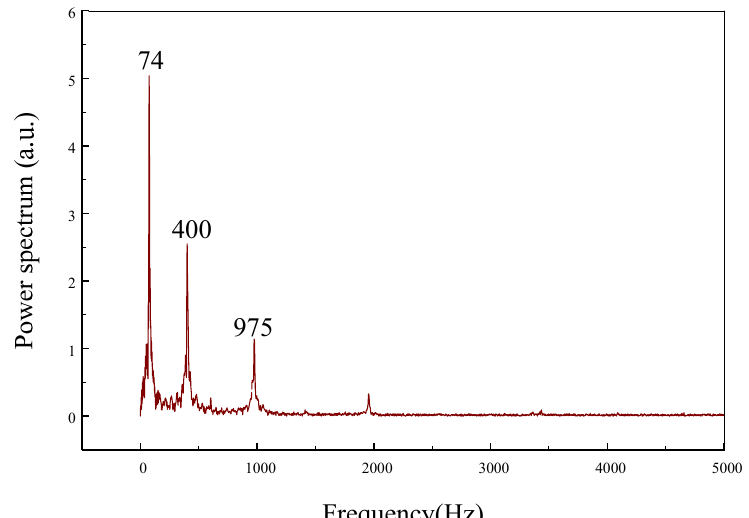
Figure 9. Frequency spectrum of the smart cantilever beam.